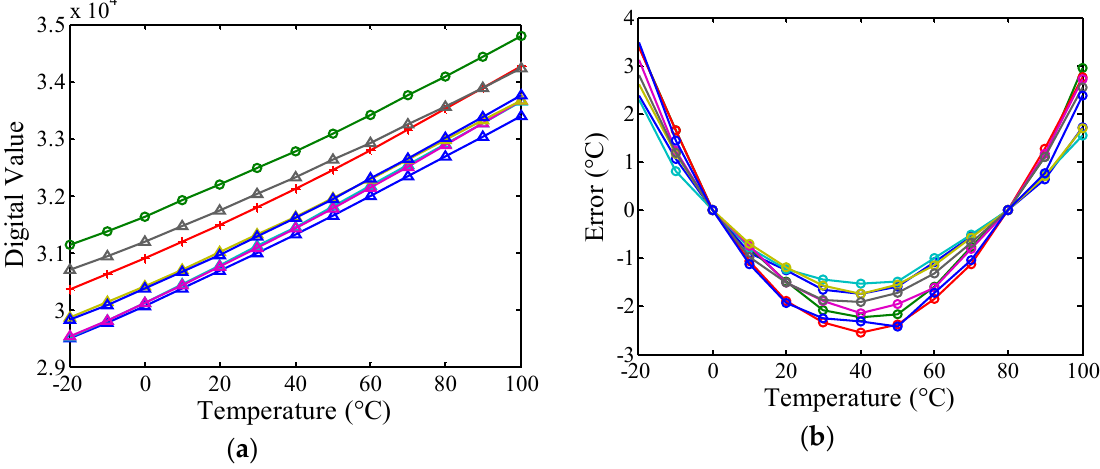
Figure 12. ( a ) Measured transfer curves of the simple smart temperature sensor for eight FPGA chips; ( b ) Inaccuracies of the simple smart temperature sensor after two-point calibration.